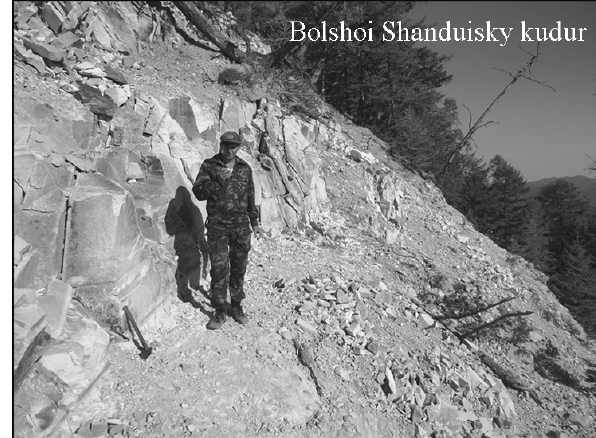
Figure 4. The Bolshoi Shanduisky kudur at the base of Mount Solontsovaya, at the head of the Malyi Solontsovyi stream on a bedrock exposure of the Solontsovsky palaeovolcano caldera sed- iment. Animals actively eat loosened, weathered and partly clayed landwaste of zeolitic ash tuff and tuffites of rhyolite composition (I. V. Seryodkin in photo).